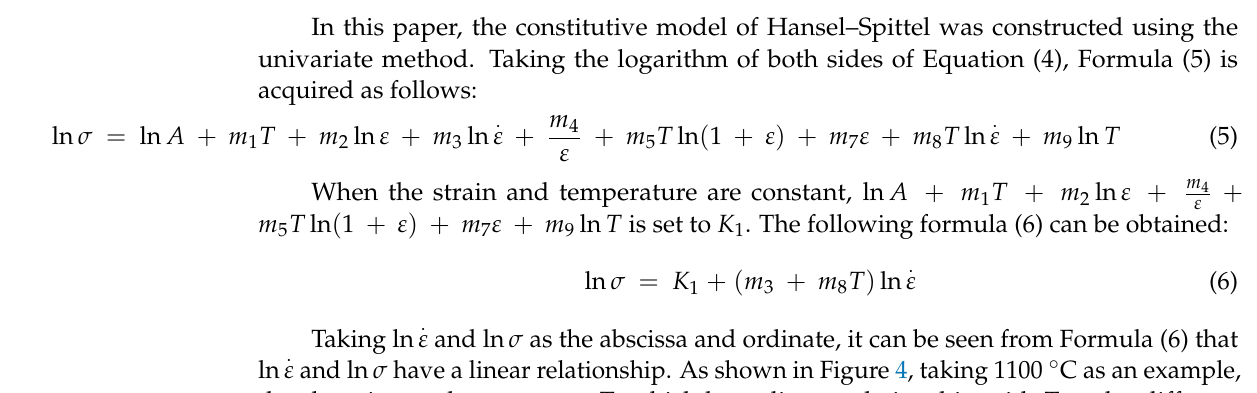
Figure 4. Relationships between ln and ln at 1100 °C.